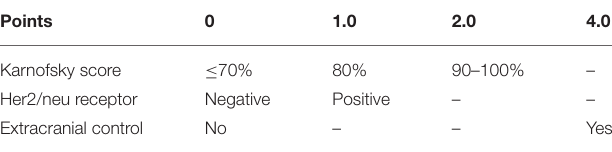
TABLE 3 | Breast cancer scoring tool for radiosurgery (bSRS).